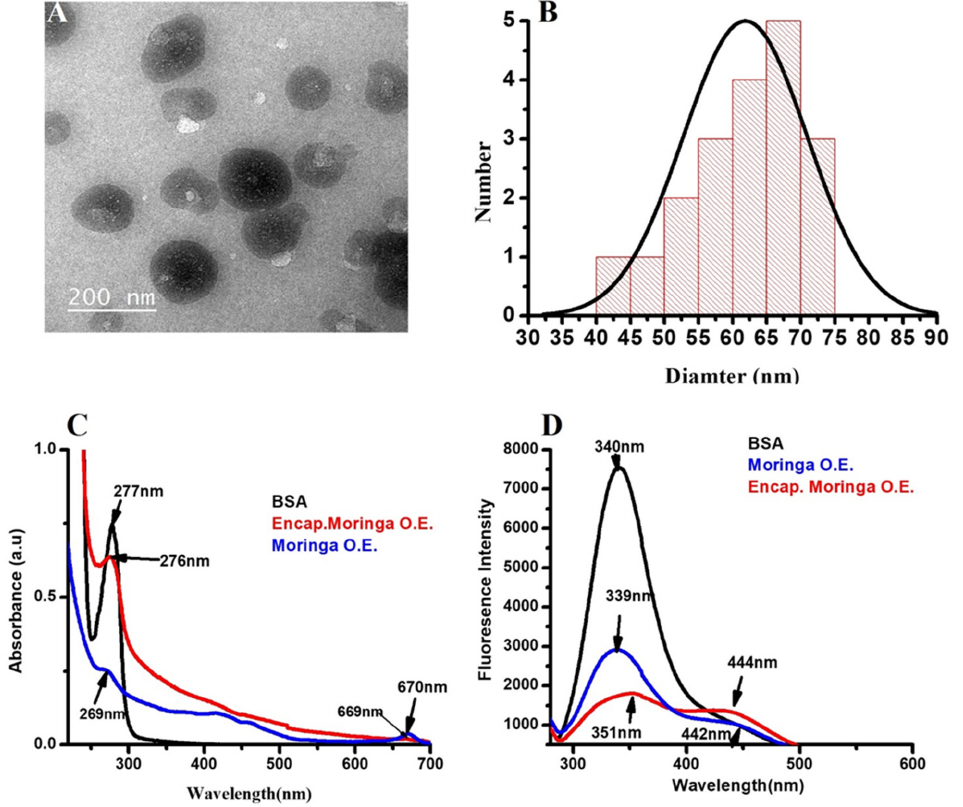
Figure 2. Characterization of MOLE NPs. ( A ) TEM image. ( B ) Quantification of NP diameter by using image J and Origin 8 program. ( C ) UV-Visible spectrophotometer for MOLE, BSA and Encap. MOLE. ( D ) Fluorescence spectrophotometer for fluorescence intensity of BSA, MOLE and Encap. MOLE.